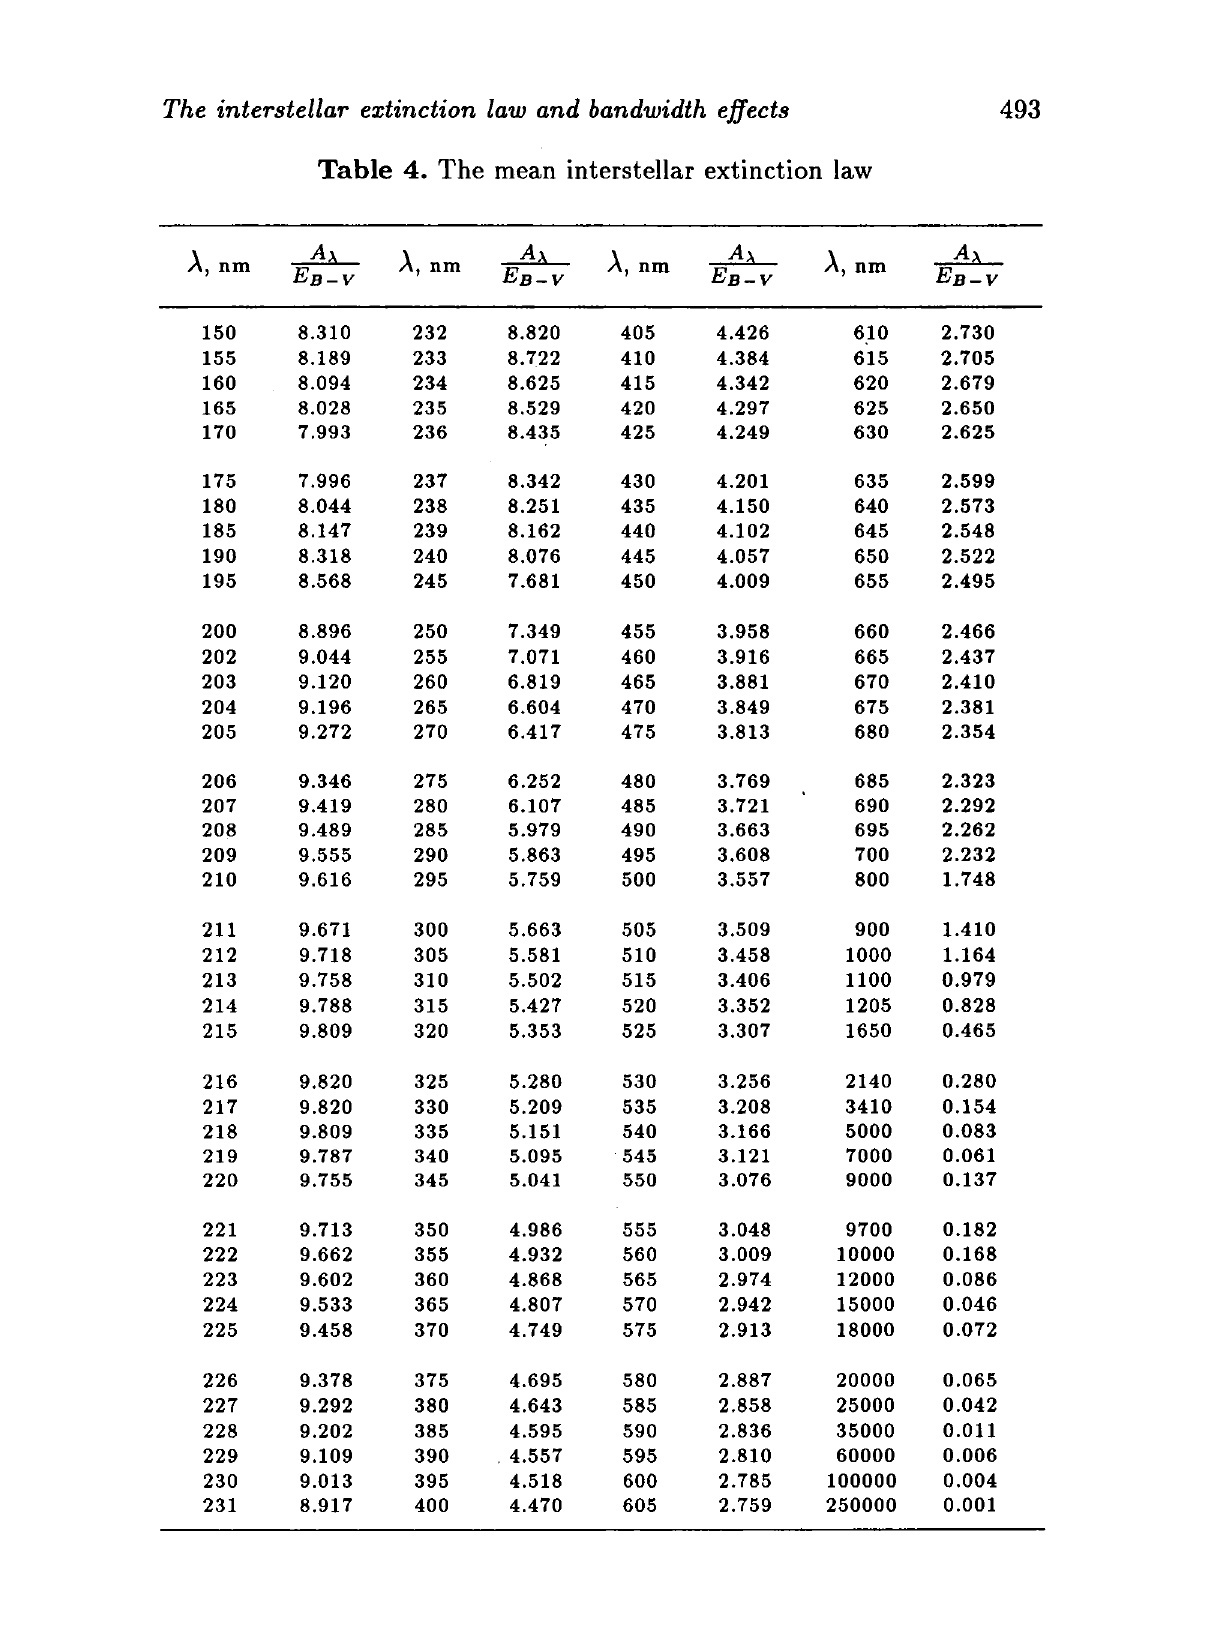
Table 4. The mean interstellar extinction